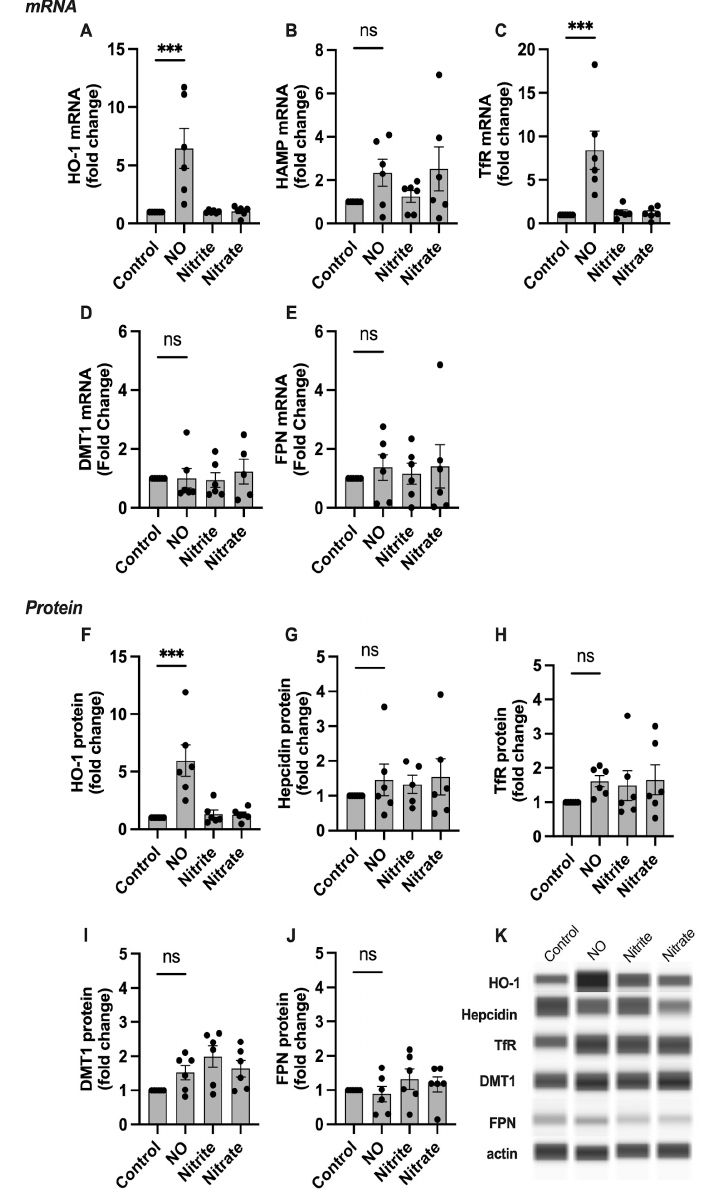
Figure 4. The effect of NO on iron handling gene expression in human placental villous explants. ( A – E ) qPCR results, ( F – J ) protein analyses. Representative blots are shown in ( K ). HO-1 and TfR mRNA levels are significantly increased in the group treated with NO compared to the untreated controls. Protein abundance of HO-1 is significantly increased in the group treated with NO compared to the untreated controls. No significant change in expression is seen in the rest of the genes studied. HO-1: heme oxygenase 1, HAMP: hepcidin antimicrobial peptide, TfR: transferrin receptor, DMT1: divalent metal transporter 1, FPN: ferroportin 1. Data are reported from at least three independent experiments as mean ± SD, *** p < 0.001, ns = not